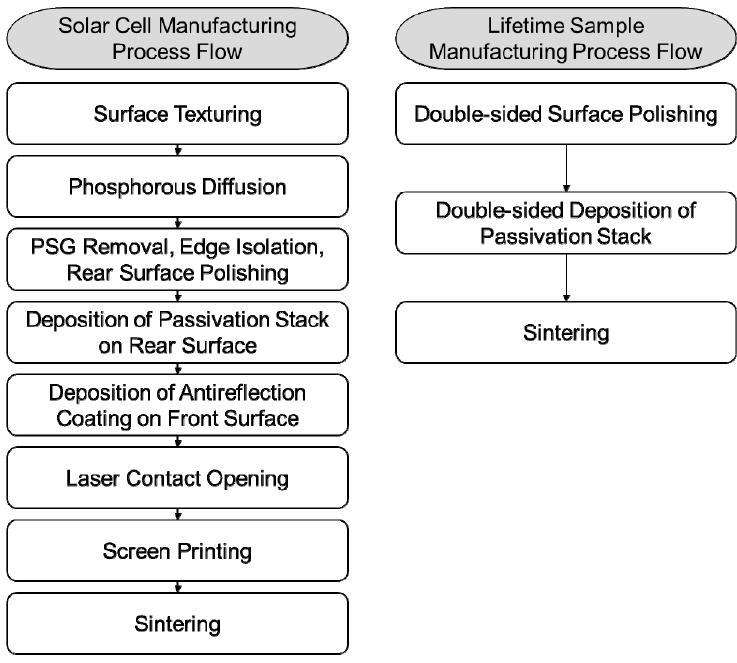
Figure 1. Manufacturing process flows of multicrystalline silicon (mc-Si) passivated emitter and rear cell (PERC) solar cell and corresponding lifetime sample.